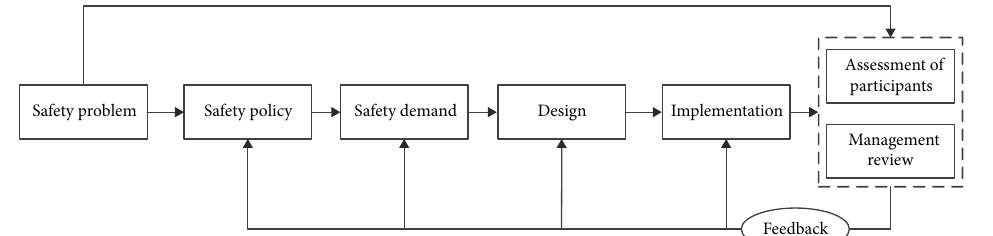
Figure 2. Implementation steps of